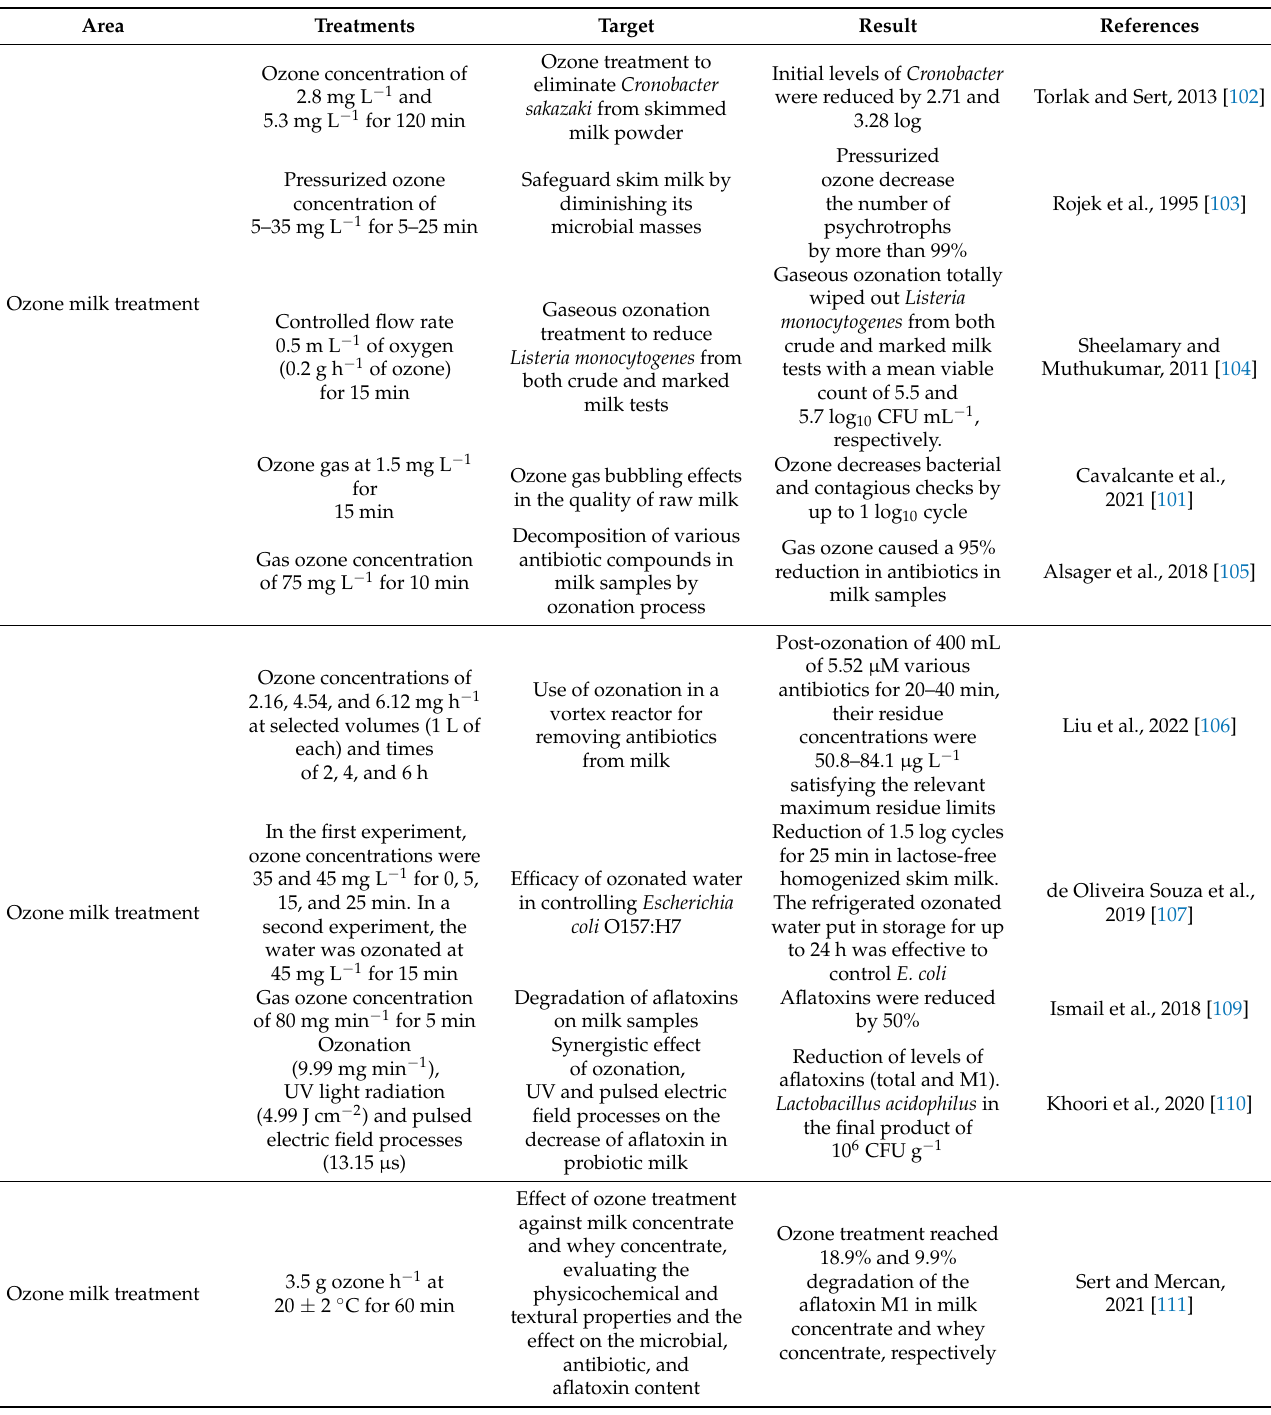
Table 4. Ozone milk